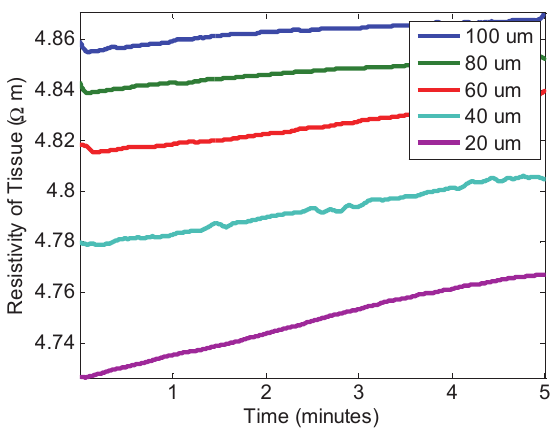
Fig. 9: Measured resistivity of acellular alginate during small strain indentation experiments calculated from eq. 32. Legend denotes final indentation depth.